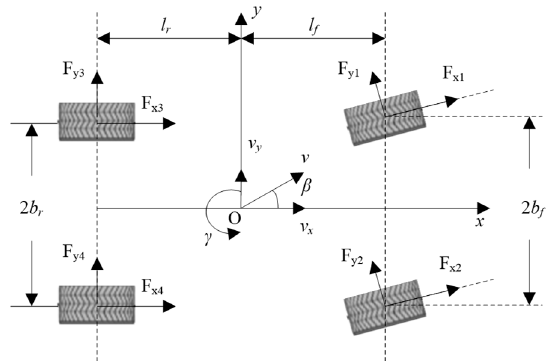
Figure 1. Three-degree-of-freedom vehicle dynamics model.